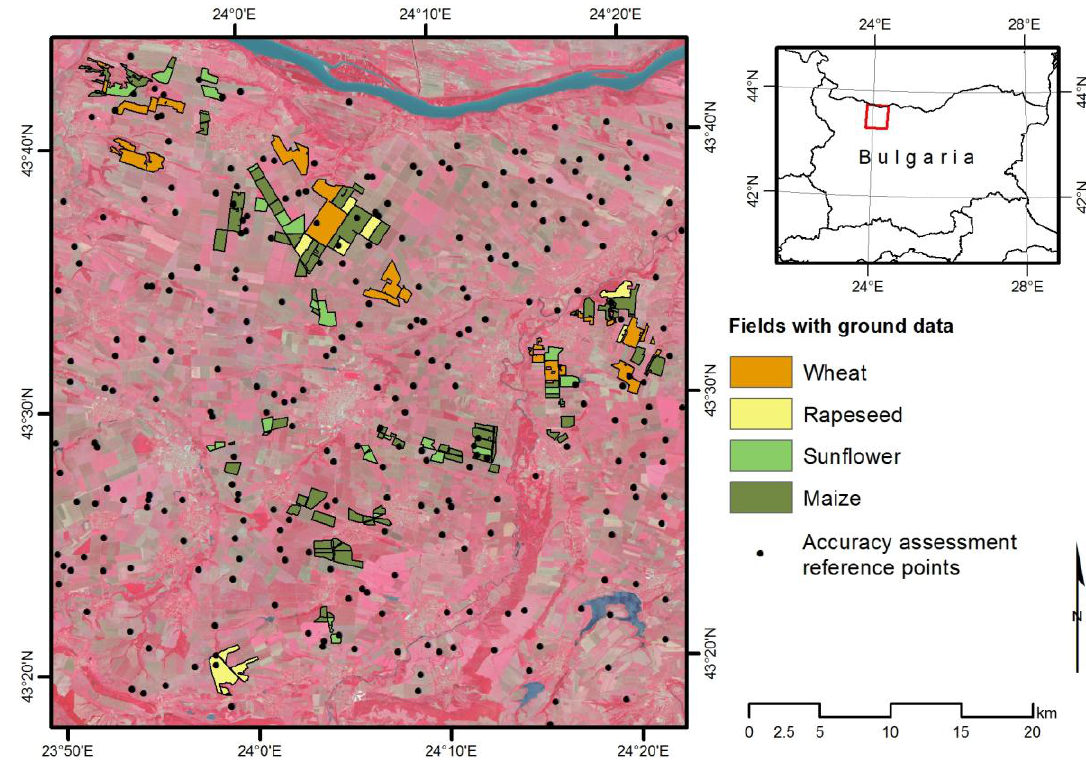
Figure 1. Zlatia test site in Bulgaria. Background false color (RGB) composite (bands 5-4-3) from Landsat-8 OLI acquired on 11 June 2014. The colored polygons correspond to four crop types with in situ (ground) data available (e.g., winter wheat, rapeseed, sunflower, and maize). Data from these areas are used for training purposes. The dots indicate reference points where the crop mapping accuracy was